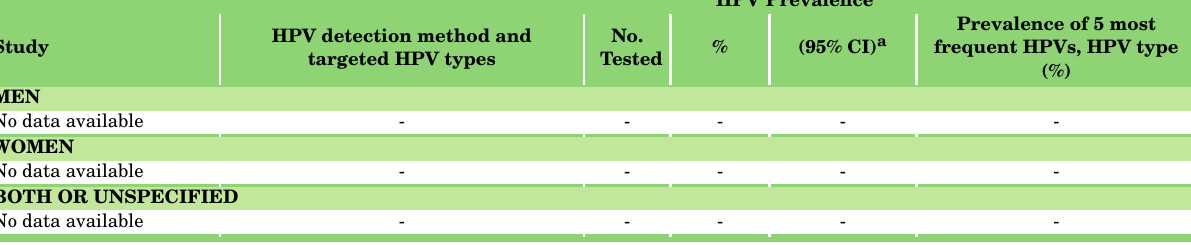
Table 37: Studies on HPV prevalence among cases of oropharyngeal cancer in Peru